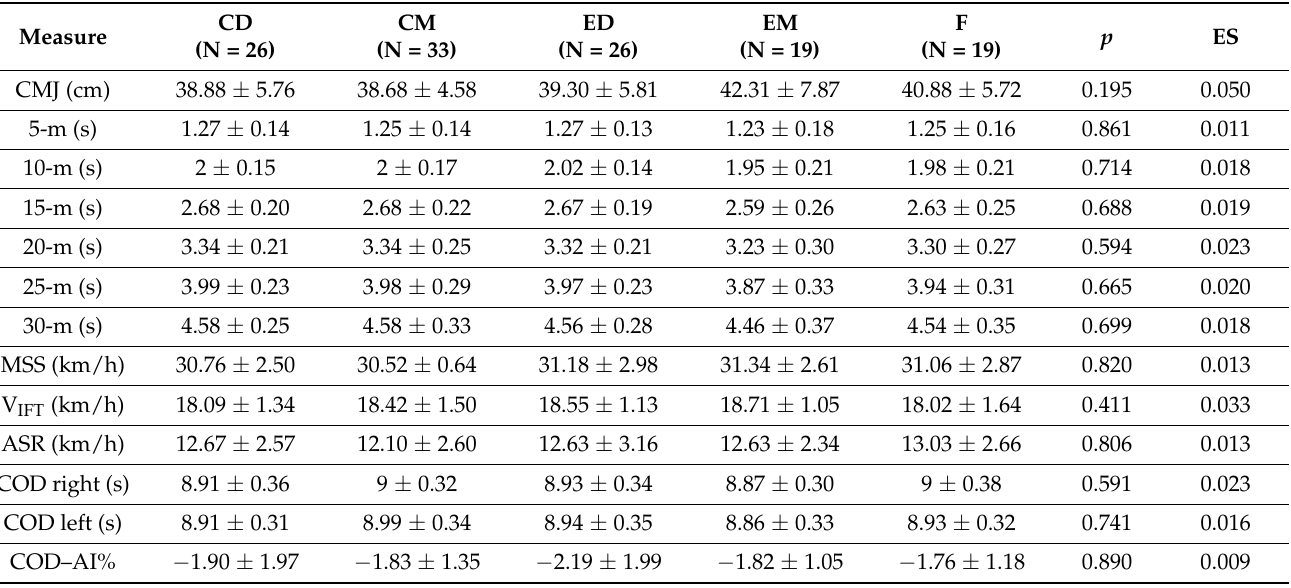
Table 4. Descriptive statistics (mean and standard deviation) for the physical fitness outcomes between playing